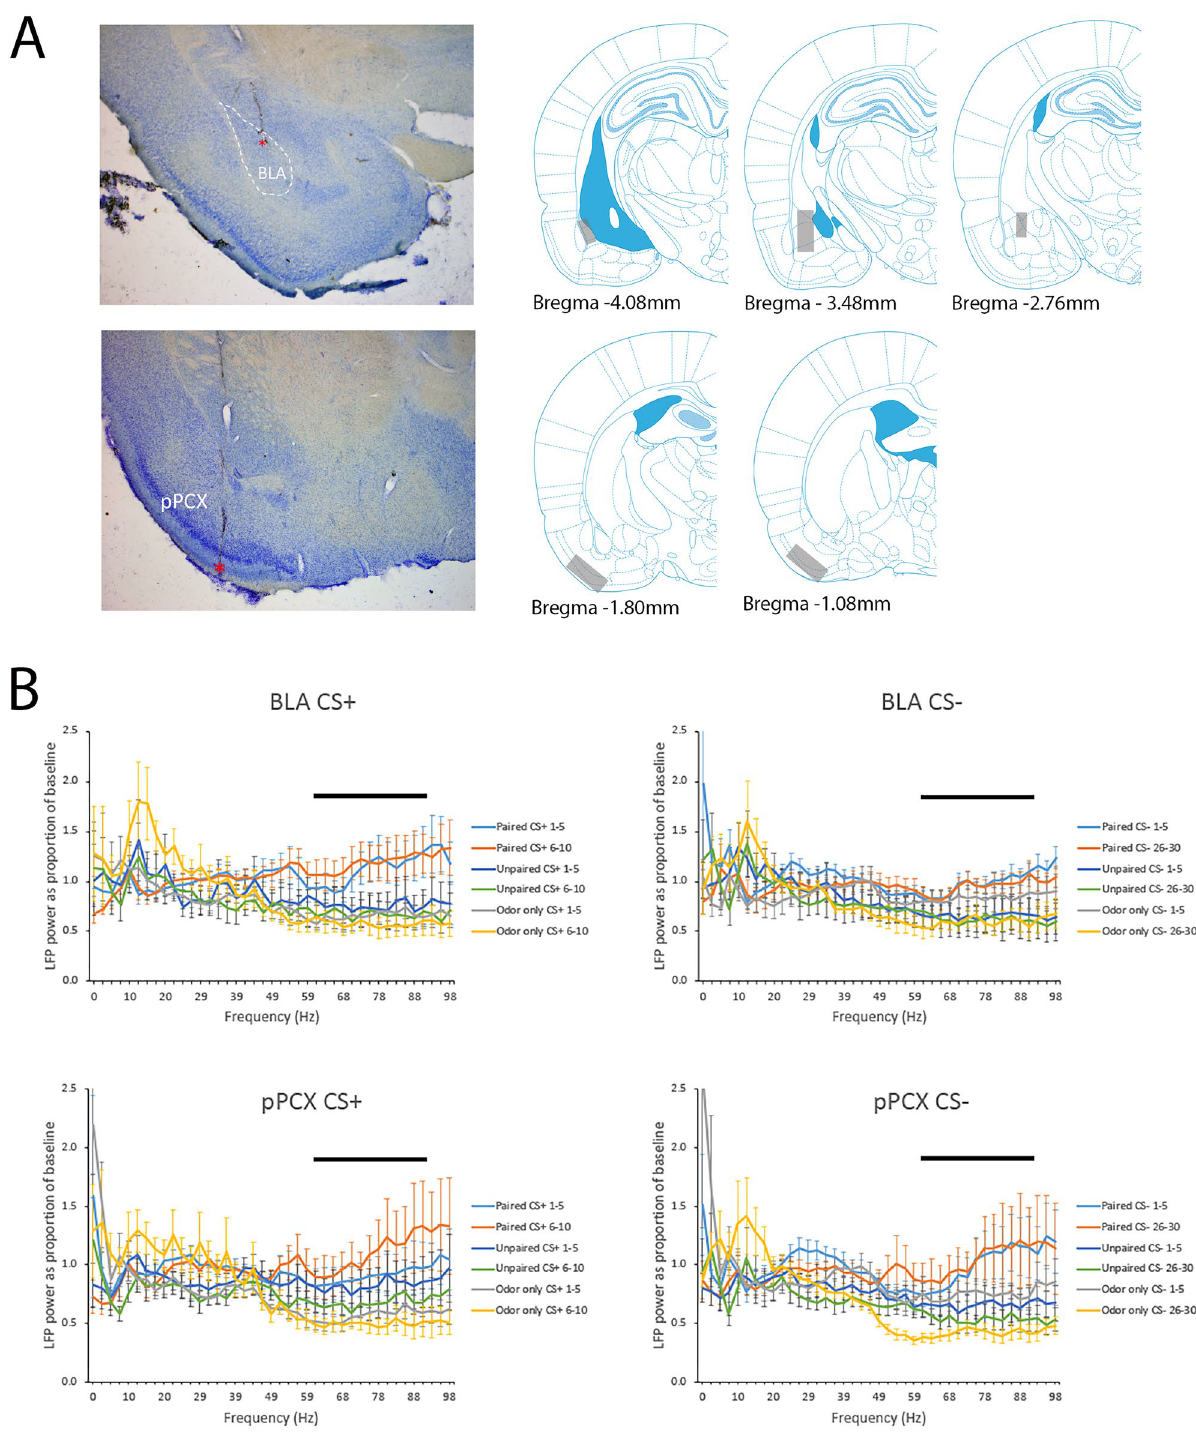
Figure 2. ( A ) Examples of electrode implants (red asterisks) in the BLA and pPCX and regional localization across animals of targeted areas. Schematic brain images were modified from Paxinos and Watson 77 . ( B ) Mean FFT’s normalized to spontaneous activity recordings taken in the homecage from the BLA and pPCX in response to the CS+ and CS− odors in Paired, Unpaired and Odor only animals. Mean activity is plotted over the first 5 and last 5 training trials for each odor in each location. The most robust differences between Paired and control groups were in the high gamma band (61–90 Hz), highlighted by the horizontal